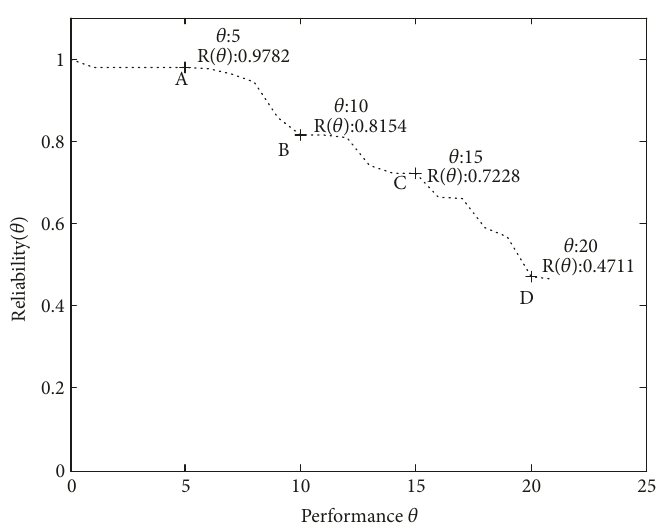
Figure 4: Curve of reliability at different performance levels. Table 4: Comparison of reliability improvement after the CCF is removed from one single